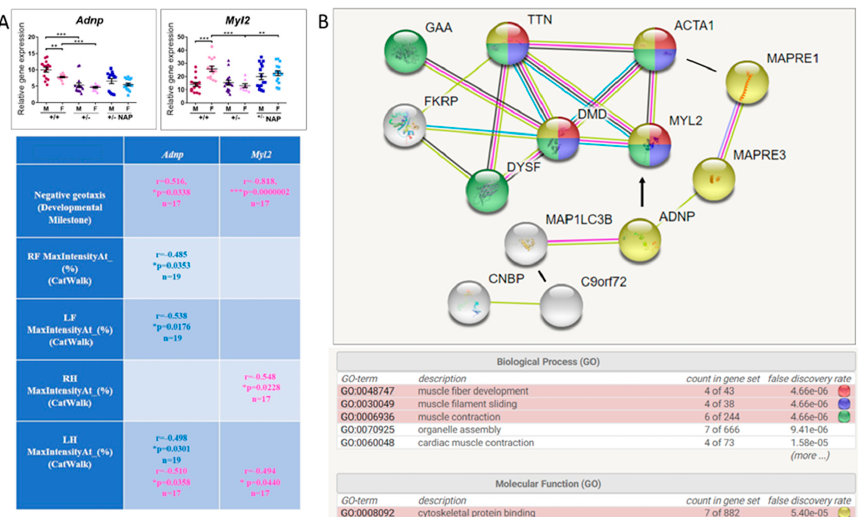
Figure 6. Adnp and the Adnp-regulated Myl2 correlate with muscle function and behavior. ( A ) Gastrocnemius muscle total RNA was extracted from 19-27-day-old mice (males: Adnp +/+ n = 5, Adnp +/– n = 5, Adnp +/+ NAP n = 4, Adnp +/– NAP n = 5; females: Adnp +/+ n = 5, Adnp +/– n = 3, Adnp +/+ NAP n = 4, Adnp +/– NAP n = 5). Results were normalized to Hprt . A two-way ANOVA with Tukey’s post hoc test revealed significant differences between vehicle-treated Adnp +/+ and Adnp +/– mice and between NAP and vehicle-treated Adnp +/– mice (** p < 0.01 and *** p < 0.001). Sex differences were determined by unpaired Student’s t-test. ( B ) STRING analysis [67] was performed as described in the text, with human muscle disease proteins delineated in Figure 2 and Tables 1 and S 1 . Additional proteins included muscle actin (ACTA1), the ADNP/NAP-binding EB1 (MAPRE1), and EB3 (MAPRE3) and MAP1LC3B as well as the ADNP/NAP-regulated MYL2.